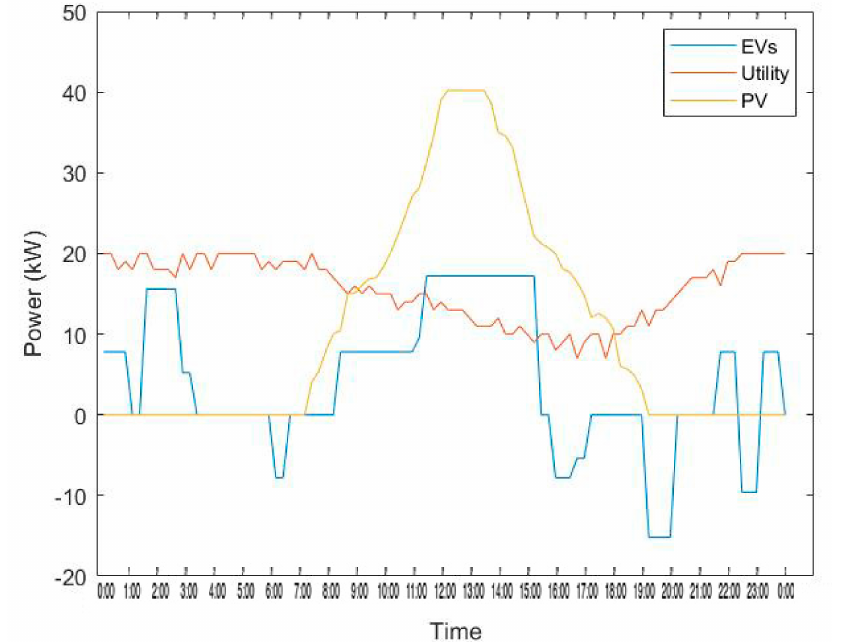
Figure 7. Utility grid power supply, EVs (V2G), and PV street generation